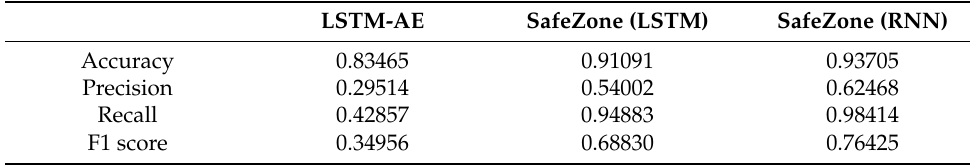
Table 1. Result of comparison